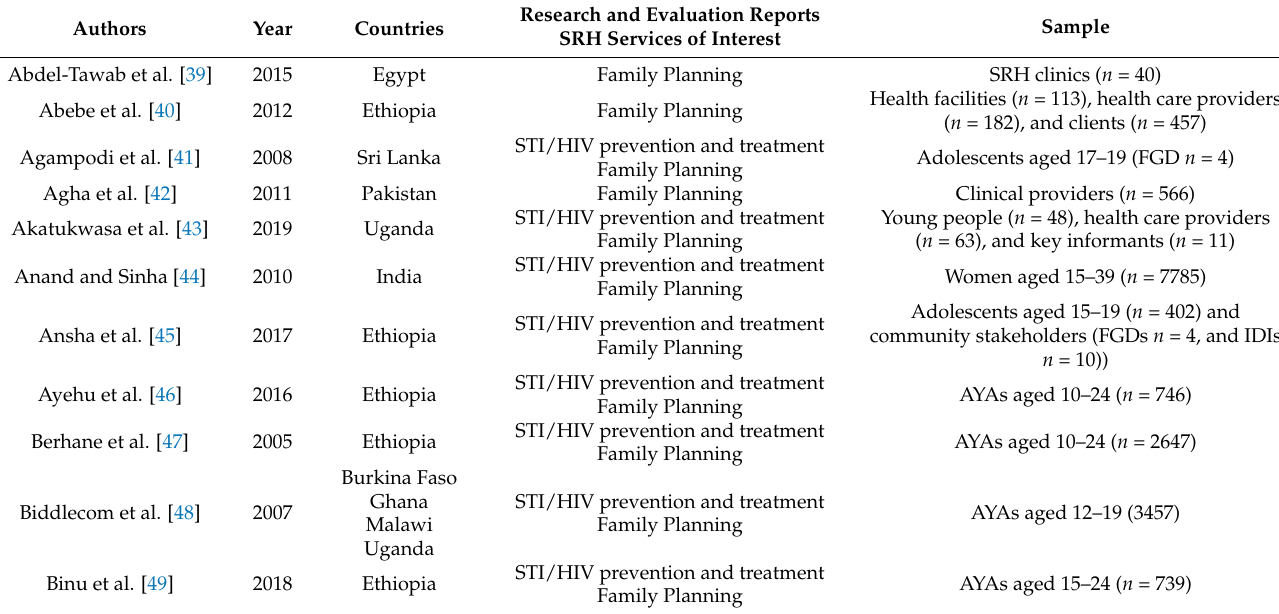
Table 3. Research studies and evaluations included in